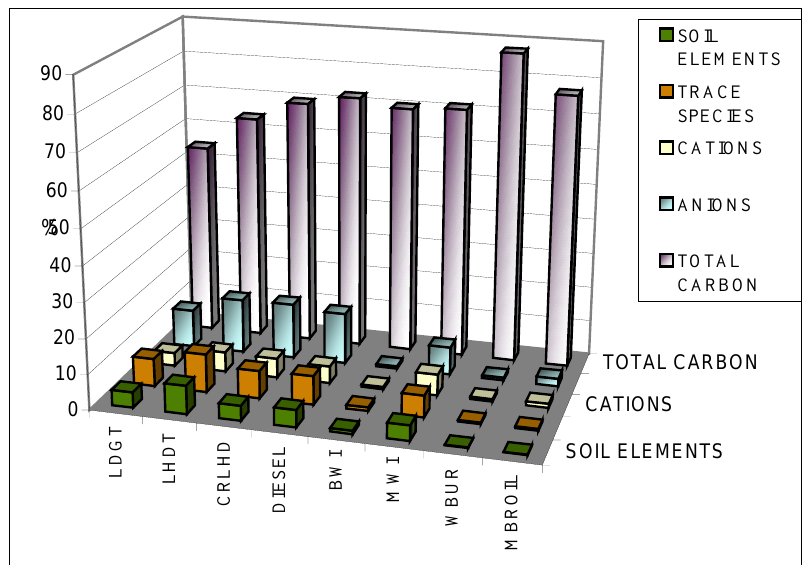
FIGURE 1. Comparison of PM 2.5 emission profiles. Total carbon (OC, EC), soil elements (Si, Al, Fe, Ca), trace elements (Ph, S, Ca, Ti, V, Cr, Mn, Fe, Co, Ni, Cu, Zn, Cd, Sn, Ba, Hg, Pb),